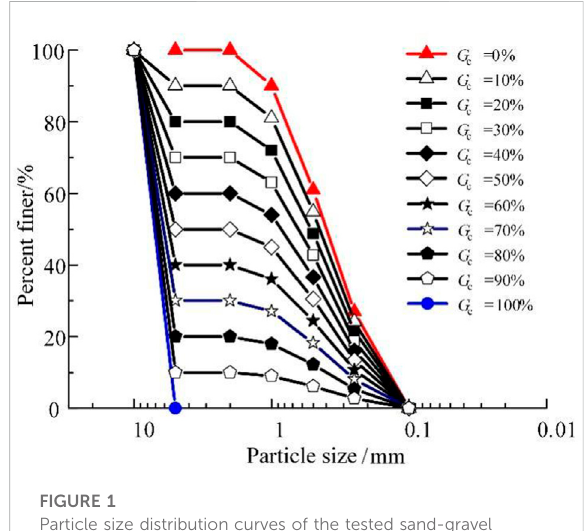
FIGURE 1 Particle size distribution curves of the tested sand-gravel mixtures.